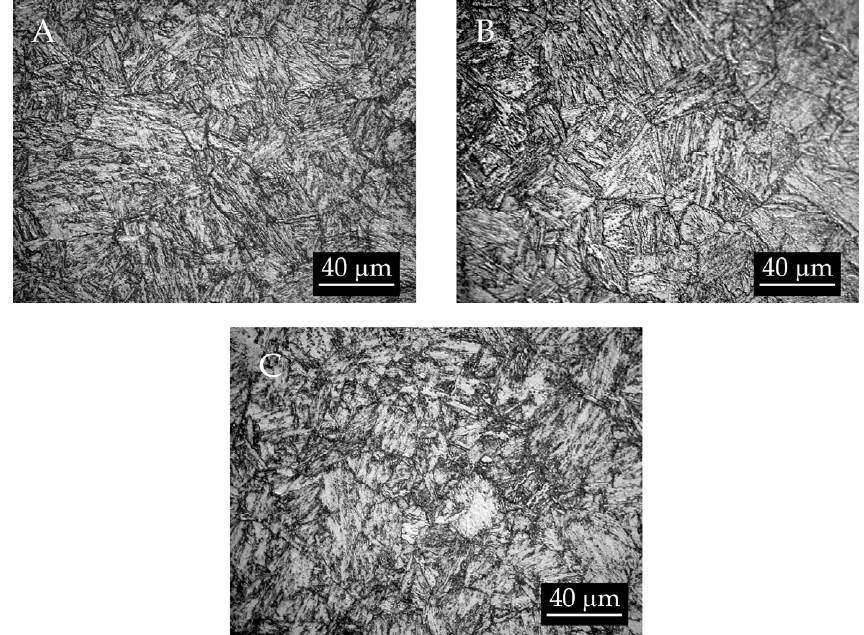
Figure 4. OM micrographs of the samples after different heat treatments: quenched and tempered at 590 °C for 6 h ( A ), quenched and tempered at 590°C for 10 h ( B ), quenched and tempered at 590 °C 6 h + 590 °C 4 h ( C ).